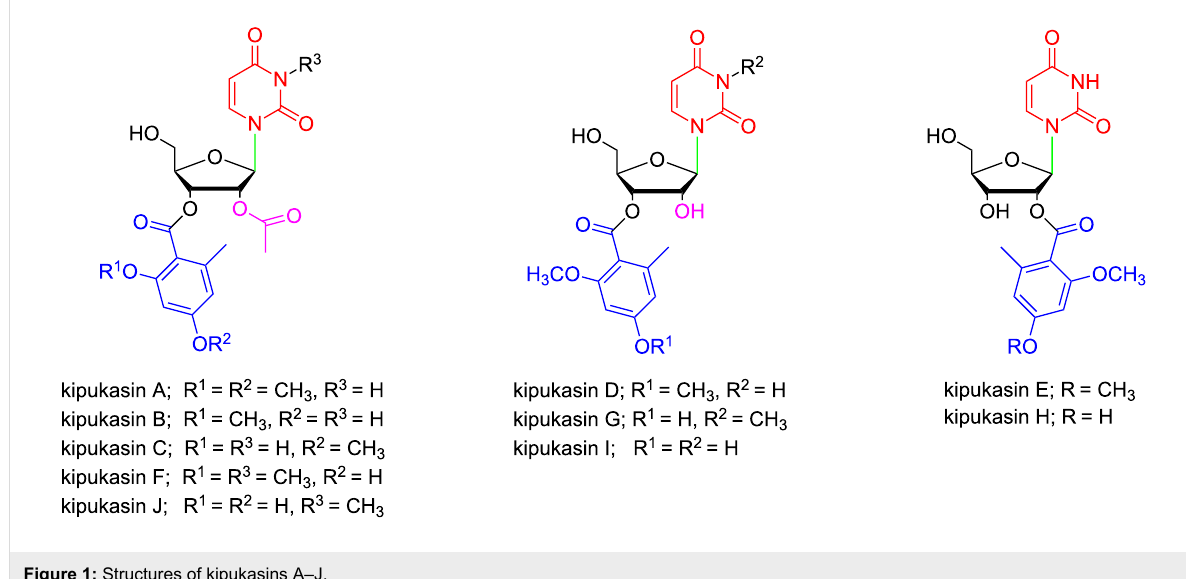
owned modest activity against Gram-positive bacteria Staphylo- coccus aureus (ATCC 29213)